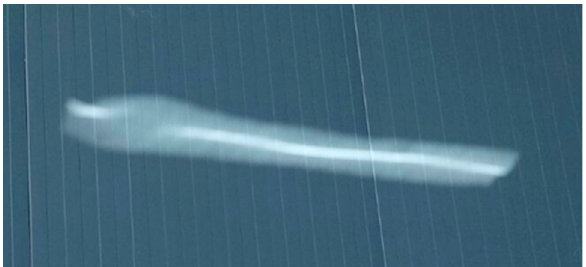
Figure 11. Reflected image for the assembly of naked mirror mechanically bended by metallic bars